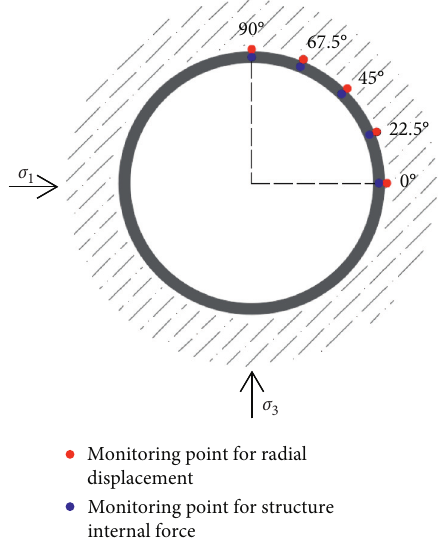
Figure 12: Layout of monitoring